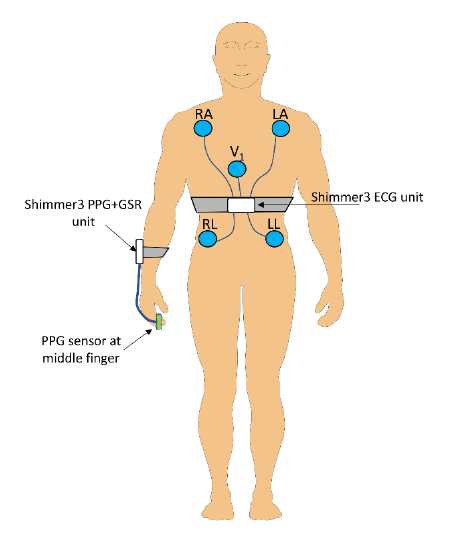
Figure 1. Placement of Shimmer3 measurement units (white boxes), ECG electrodes (blue circles) and the PPG sensor (green